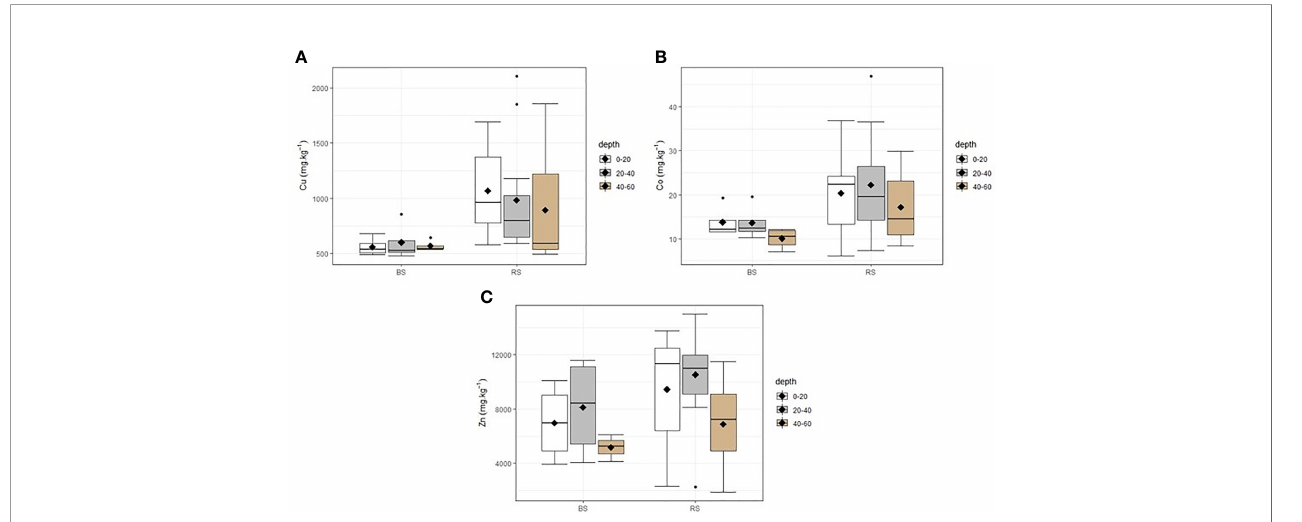
FIGURE 2 | Available trace metal concentration (mg kg − 1 ) in the reclaimed soil (RS) and on bare soil (BS) at different depth measurements (0 – 20cm, 20 – 40cm, and 40 – 60 cm). n = 12 for RS, and n = 4 for BS. (A) : Cu, (B) : Co, (C) : Zn.